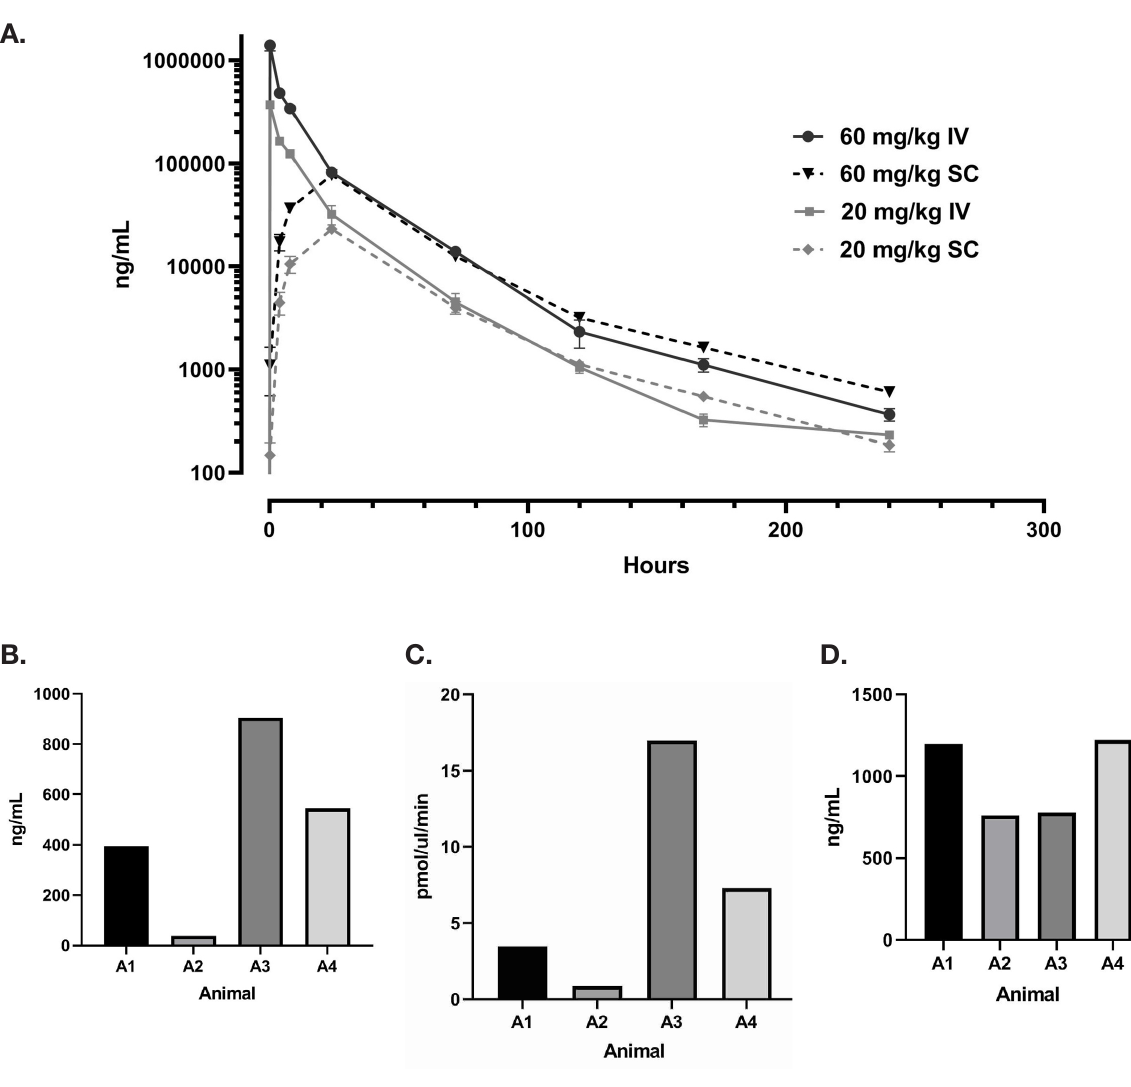
Figure 5. Rat pharmacokinetics study. (A) G921 levels assessed by ECL-MI in serum samples after intravenous and subcutaneous dosing at 20 mg/kg and 60 mg/kg each. Serum levels of G921 (mean +/- SEM). Rat study assessing exposure of G921 in lung and urine. (B) G921 levels (ng/mL) measured in rat BAL fluid by ECL-MI. Animal-to-animal variation possibly due to variation in BAL extraction technique. (C) ACE2 enzyme activity levels in rat BAL fluid measured by ACE2 enzyme activity assay (pmol/μL/min). (D) G921 levels (ng/mL) measured by ECL-MI in rat urine. A1-A4 represents individual